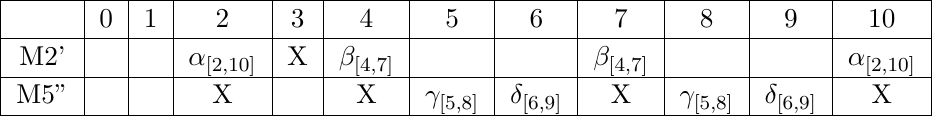
Table 3 . M2’ brane and M5"